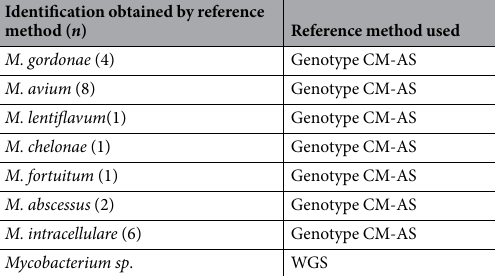
Table 3. Mycobacteria not identified by MALDI-TOF.